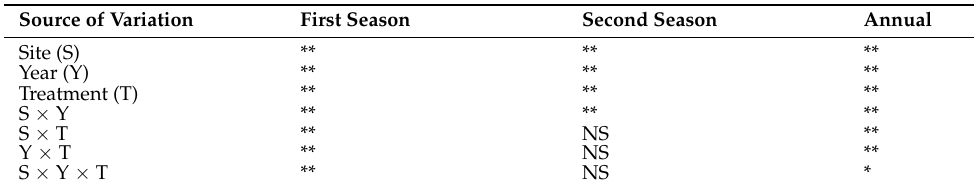
Table 2. Analysis of variance for the crop yields in the first and second seasons and annually from 2016 to 2018 at Wuxue and Jingmen, China.